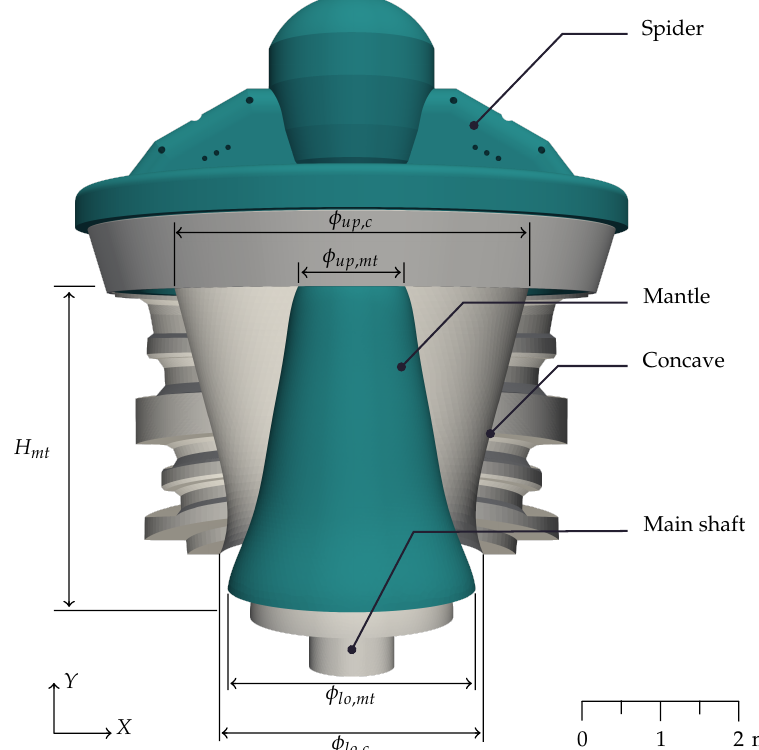
Figure 1. Metso 60-110 gyratory crusher. Concave cut in half, mantle, main shaft, and spider are presented. Some geometrical parameters are presented, such as the height, H mt ; upper diameter, φ up , mt ; and lower diameter, φ lo , mt , of the mantle ( mt ), and the upper diameter, φ up , c ; and lower diameter, φ lo , c , of the concave ( c ). A geometric scale is drawn at the right bottom.